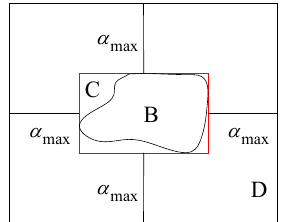
Figure 3. Schematic for the construction of the EBR